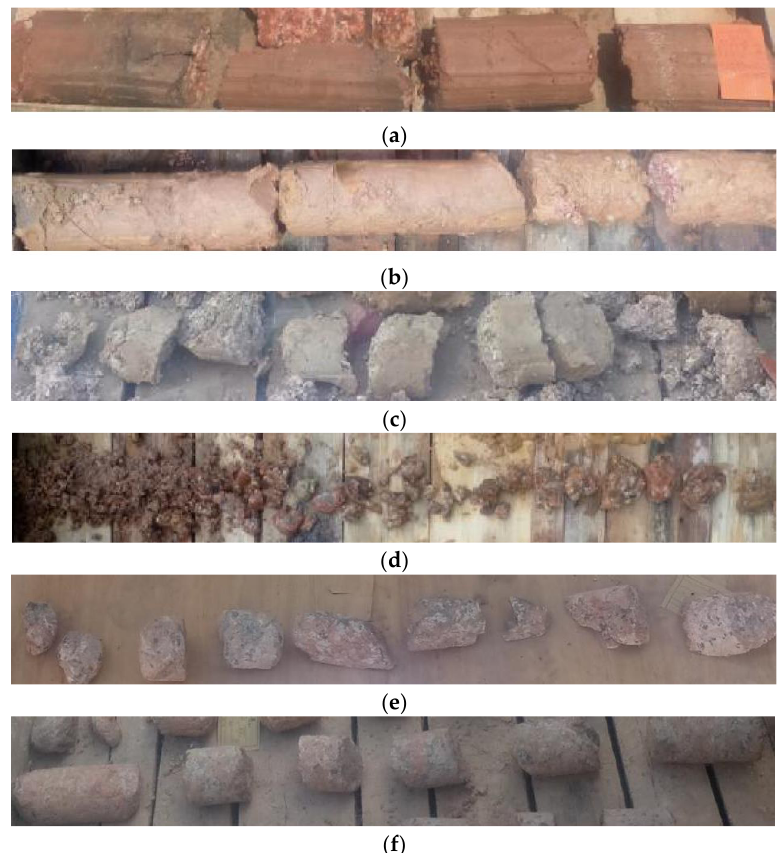
Figure 2. Soil/rock samples from bore holes: ( a ) gravelly clayey soil; ( b ) completely weathered gran- ite; ( c ) earthy strongly weathered granite; ( d ) fragmentary strongly weathered granite; ( e ) moder- ately weathered granite; ( f ) slightly weathered granite.